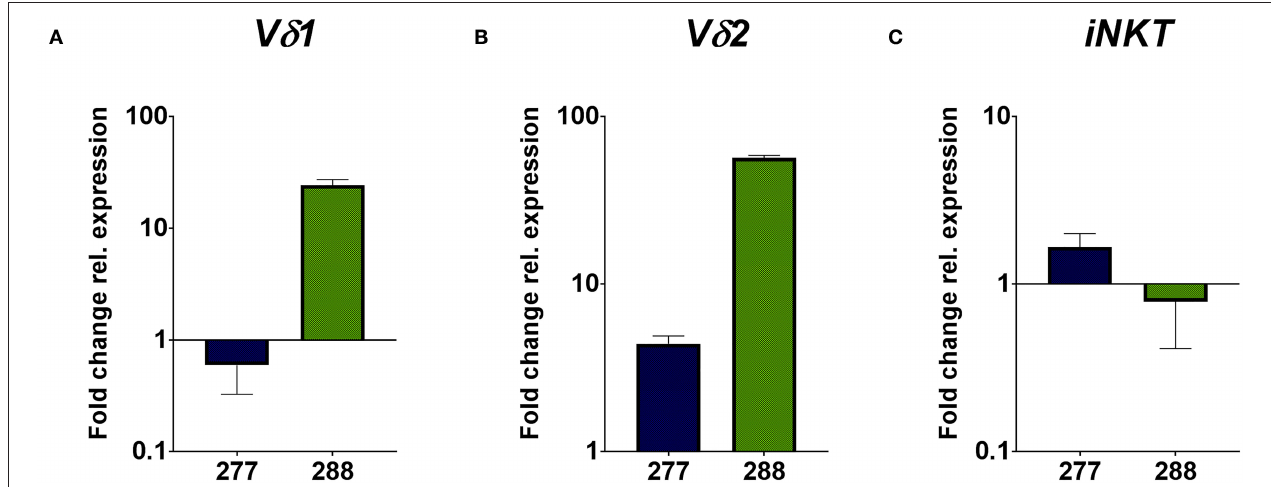
FIGURE 3 | qRT-PCR analysis of unconventional T cell-related genes. Gene expression analysis was performed by qRT-PCR method. After normalization to the housekeeping gene HPRT1 , expression quantification was calculated with the 2 − 11 ct method. Fold change of relative expression was calculated relative to pediatric normal kidney tissue. Analysis was performed in triplicates. (A) Expression analysis of unconventional T cell-related genes show a higher expression of V δ 1 in sample 288, whereas no expression of V δ 1 is detectable in sample 277. (B) Expression analysis of V δ 2 show a higher fold change in sample 288 than in sample 277. (C) Expression analysis of iNKT-related TCRV α 24J α 18 gene display the tendency of higher expression in sample 277 than in